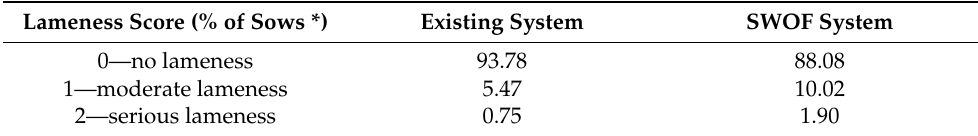
Table 7. Lameness score probability (in % of focus sows in the system) in the existing and SWOF systems.